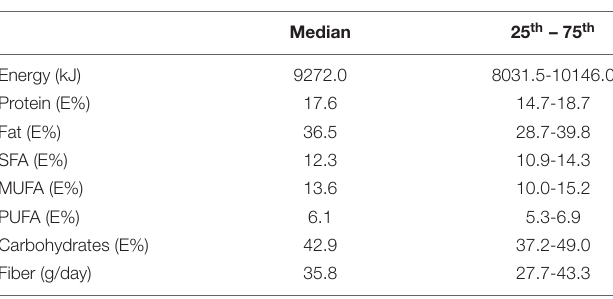
TABLE 3 | Background diet.